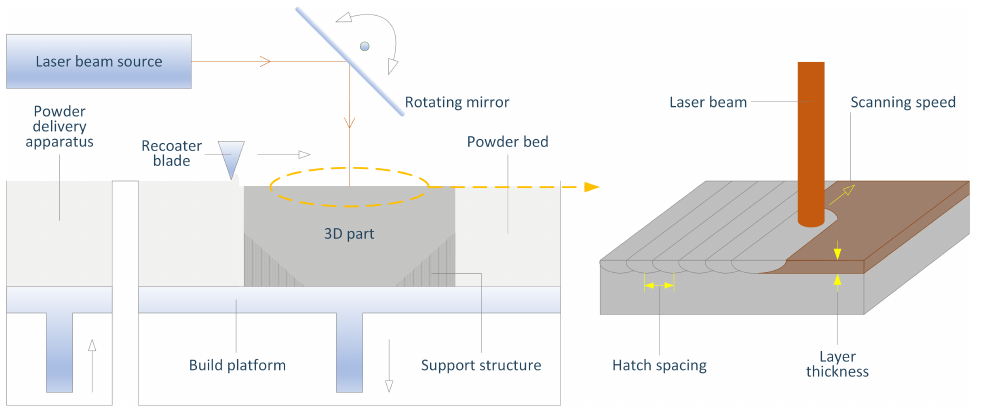
Figure 1. Schematic diagram of the LPBF